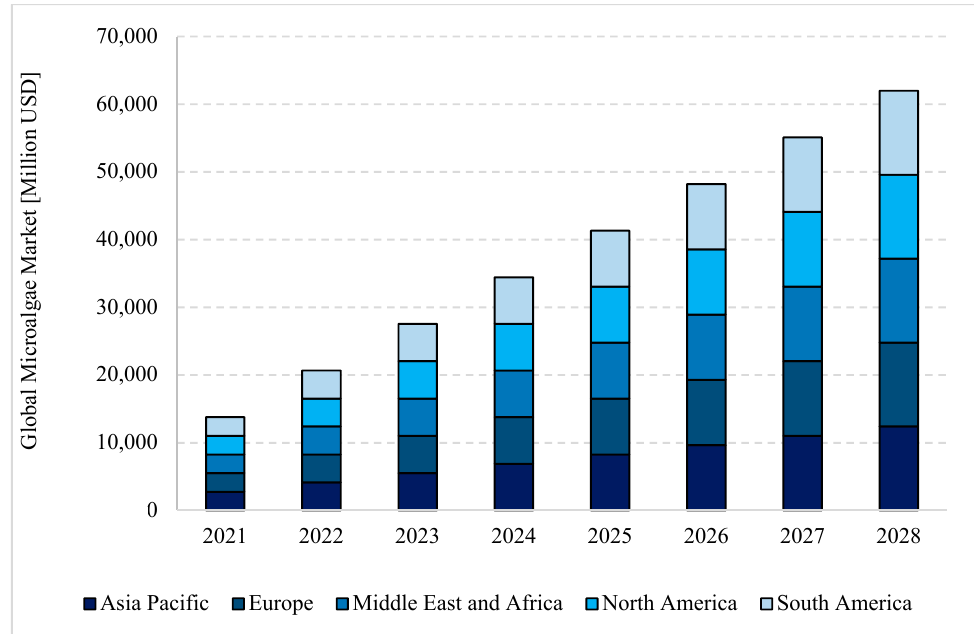
Figure 6. Global prospects for development of microalgae ‐ based technologies [57].